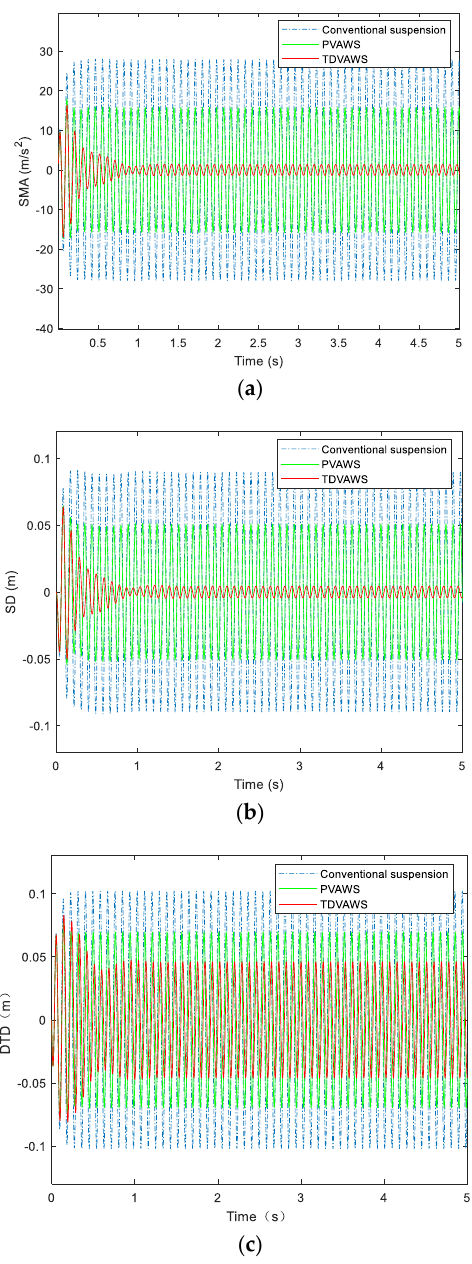
Figure 7. Simulation comparison under harmonic excitation. ( a ) sprung mass acceleration comparison chart; ( b ) suspension deflection comparison chart; ( c ) dynamic tire deflection comparison